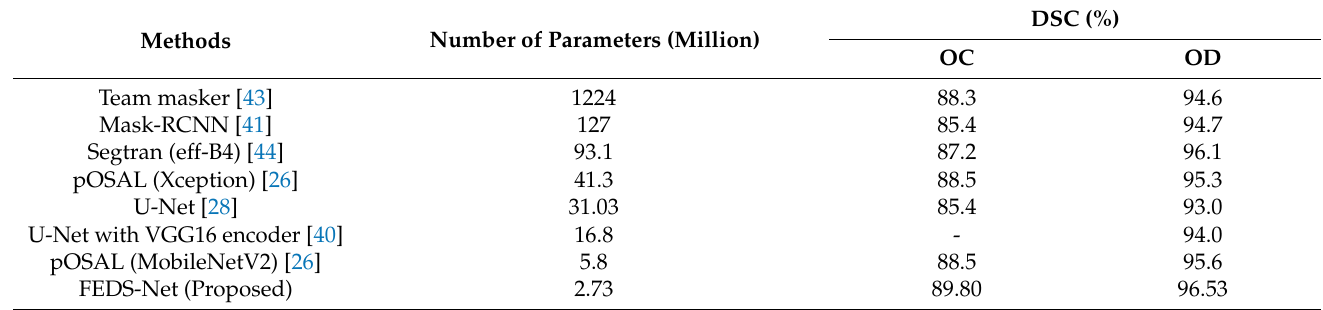
Table 4. Comparison of trainable parameters with those of the existing methods. (OC: optic cup; OD: optic disc; DSC: dice similarity coefficient).